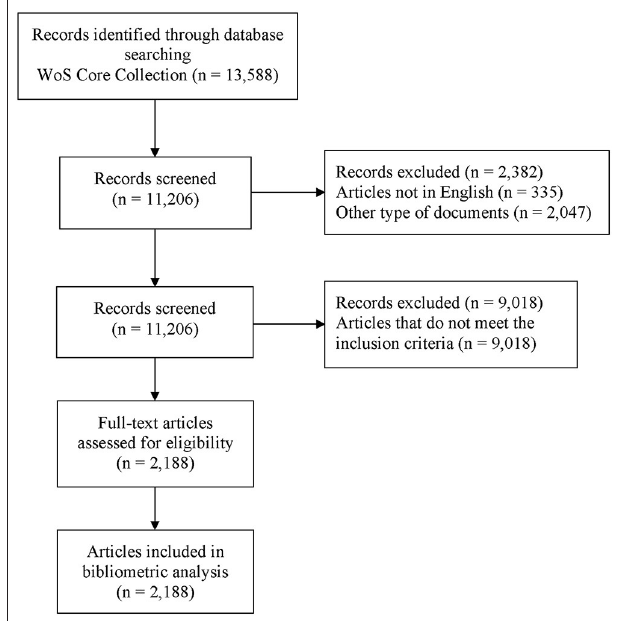
FIGURE 1 | Flowchart of study identification and